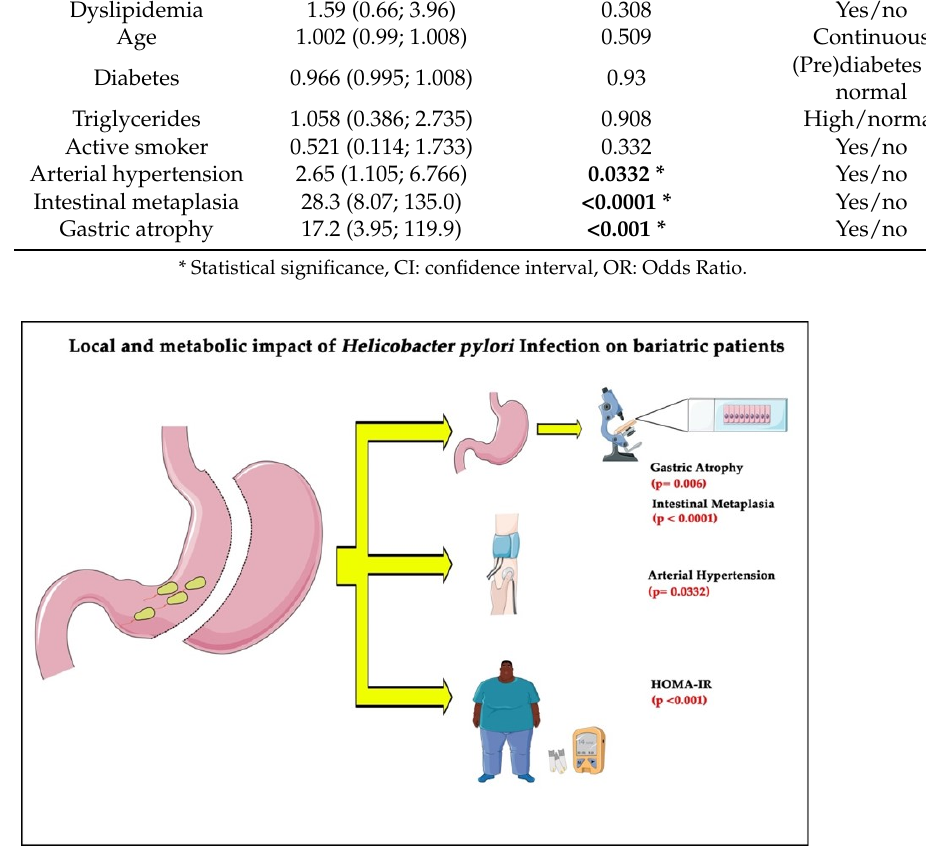
Figure 1. Patients undergoing bariatric surgery were significantly associated with gastric atrophy, intestinal metaplasia, arterial hypertension, and increased insulin resistance when infected with Hp , compared to the noninfected patients. HOMA–IR, homeostasis model assessment–insulin resistance